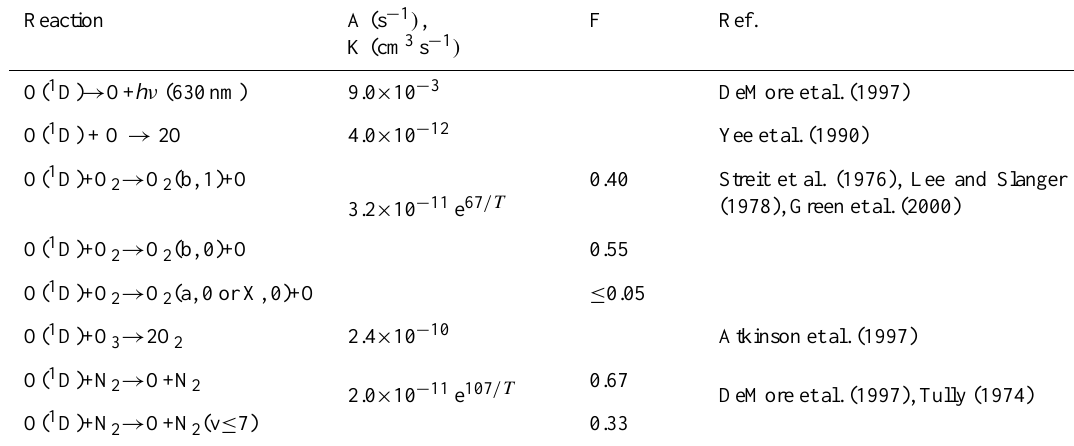
Table 2. Processes of O( 1 D) deactivation. A – Einstein coefficient, K – rate constant of reaction, other symbols as in Table 1. Reaction A (s − 1 ) , F K (cm 3 s − 1 )